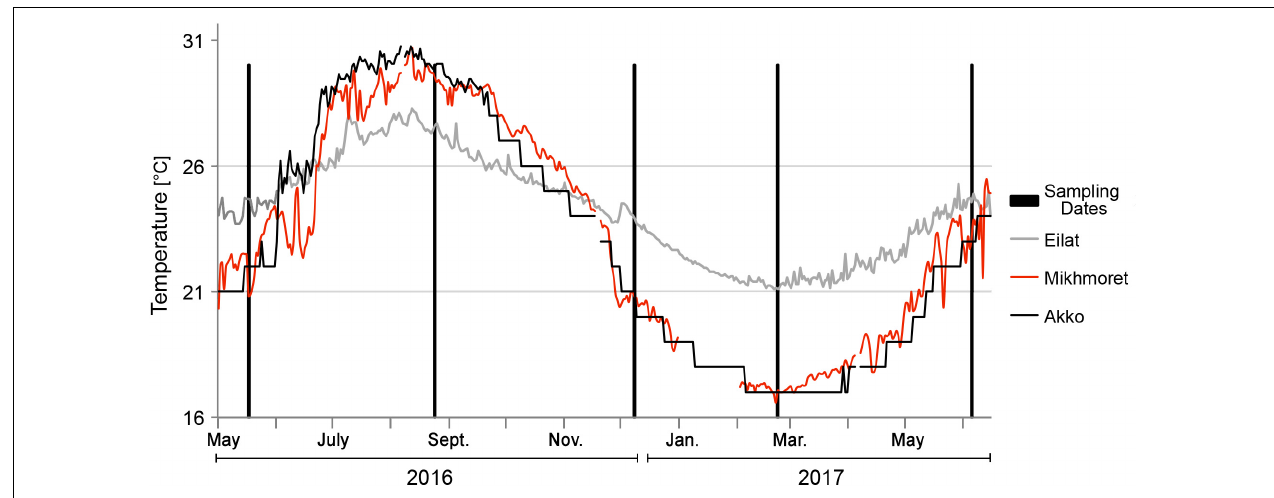
FIGURE 2 | Sampling dates and temperature data for the duration of the